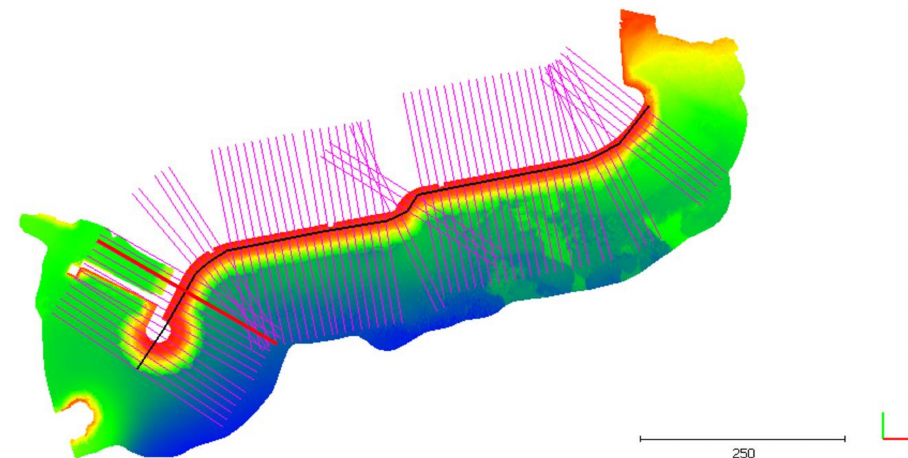
Figure 12. Sections traces ( pink ) and directrix ( black ) along the pier. Section trace number 12 is highlighted in red for considerations in the text.